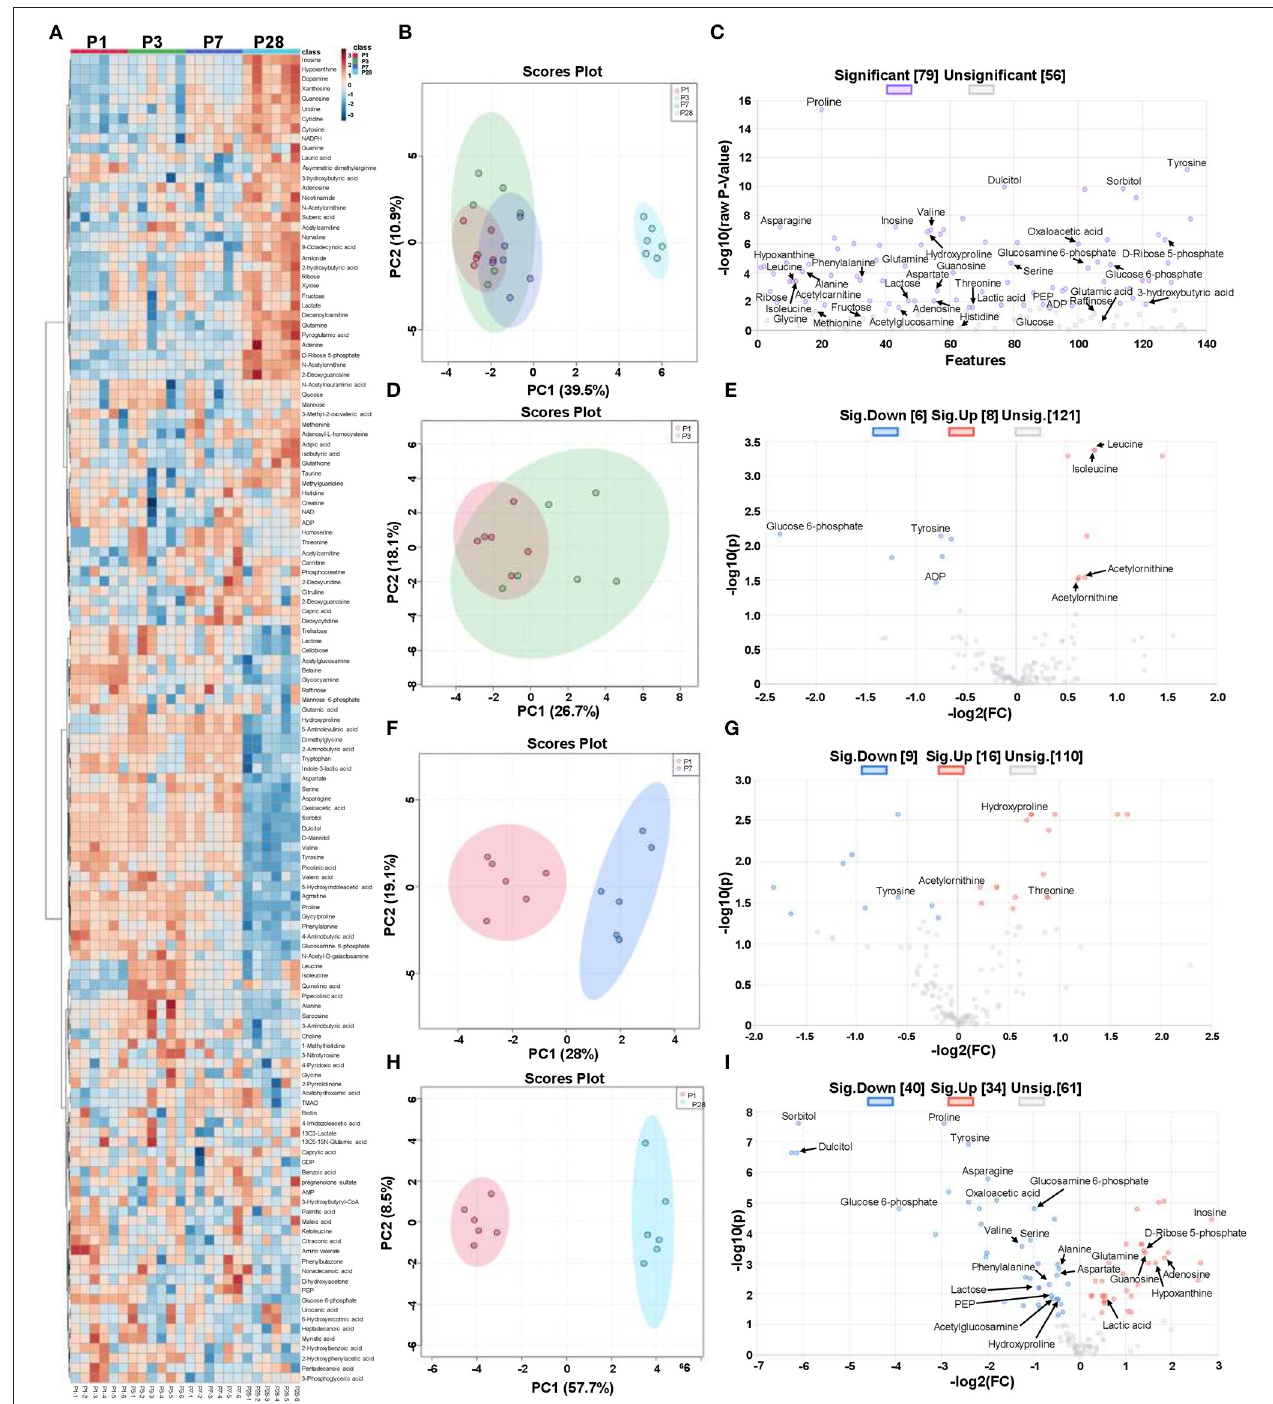
FIGURE 1 | Metabolic state in neonatal pig hearts. Four sets of left ventricular tissue samples were collected on P1, P3, P7, and P28 pigs for LC-MS/MS analysis. (A) Heat map of linear mixed effect model estimates for metabolites. (B) Principal component analysis (PCA) of metabolites from cardiomyocytes in P1, P3, P7, and P28 hearts. (C) Volcano plot of metabolites from P1, P3, P7, and P28 hearts ( p < 0.05; one-way ANOVA with Fisher’s Least Significance Difference Test). The purple and gray dots represented the significant changed and unsignificant changed metabolites. (D) PCA of metabolites from cardiomyocytes in P1 and P3 hearts. (E) Volcano plot of metabolites from P1 and P3 hearts ( p < 0.05; Student’s t -test). (F) PCA of metabolites from cardiomyocytes in P1 and P7 hearts. (G) Volcano plot of metabolites from P1 and P7 hearts ( p < 0.05; Student’s t -test). (H) PCA of metabolites from cardiomyocytes in P1 and P28 hearts. (I) Volcano plot of metabolites from P1 and P28 hearts ( p < 0.05, Student’s t -test). The red, blue, and gray dots represented the up-regulated, down-regulated, and unchanged metabolites, respectively.